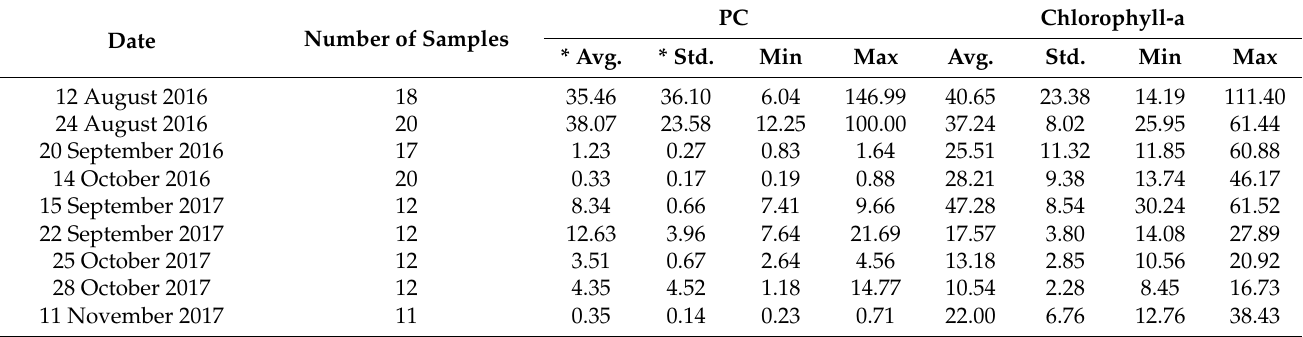
Table 1. Descriptive two-year water quality sampling statistics (mg/m 3 ) of Baekje